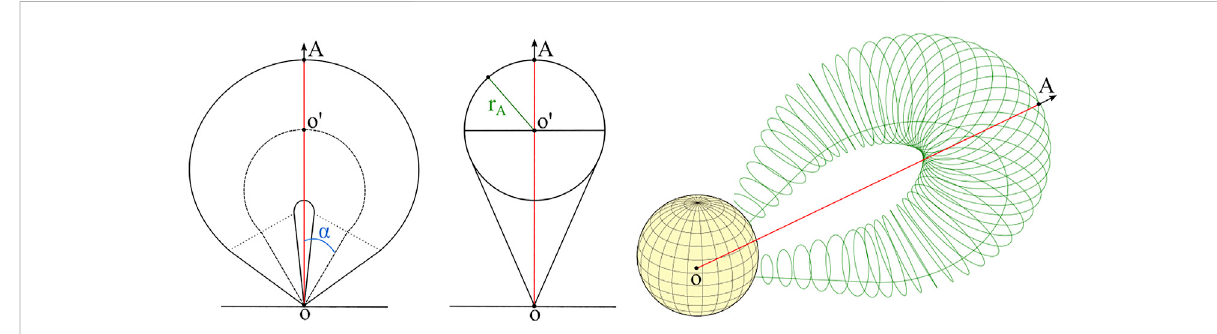
FIGURE 4 Plane sections of the GCS model (left and middle panels) showing the different parameters, and a schematic of the model mesh (right panel).